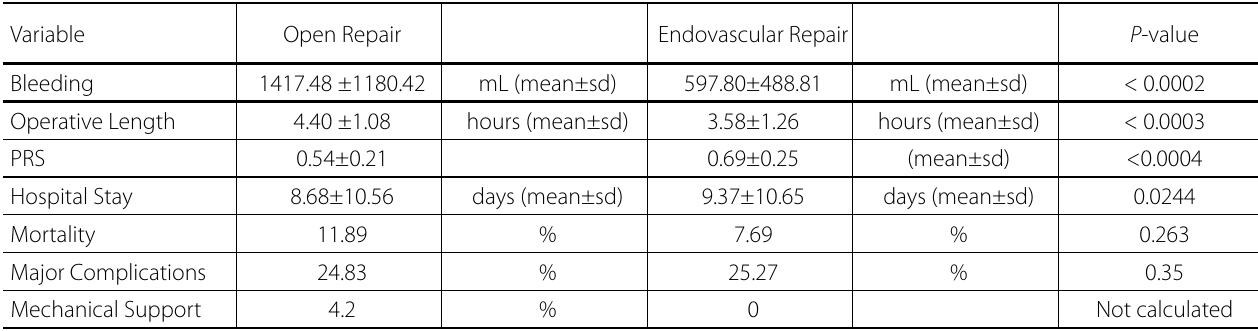
Table 2. Surgical result of OR and